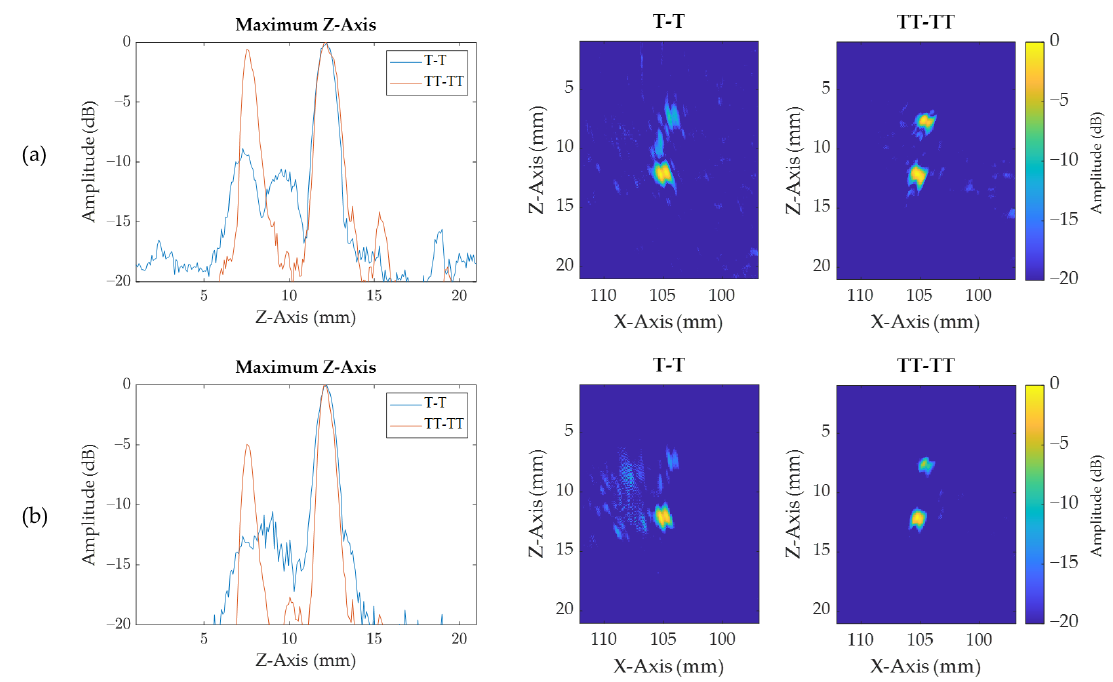
Figure 13. T–T and TT–TT views of notch B and their maximum intensity according to Z -axis for ( a ) IPCI and ( b ) TFM.